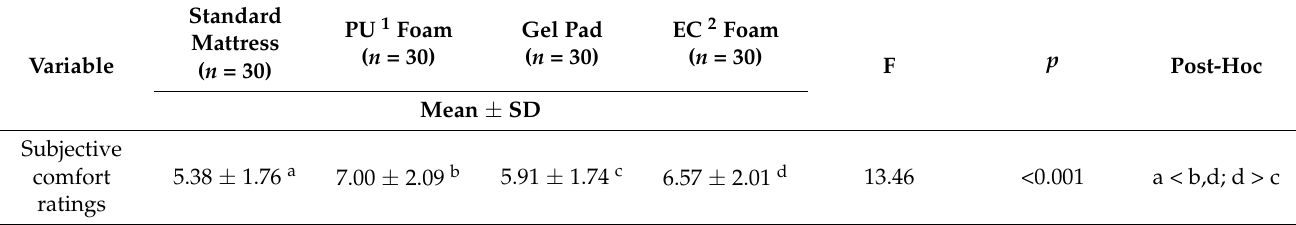
Table 3. Comparison of the subjective comfort of pressure-relieving